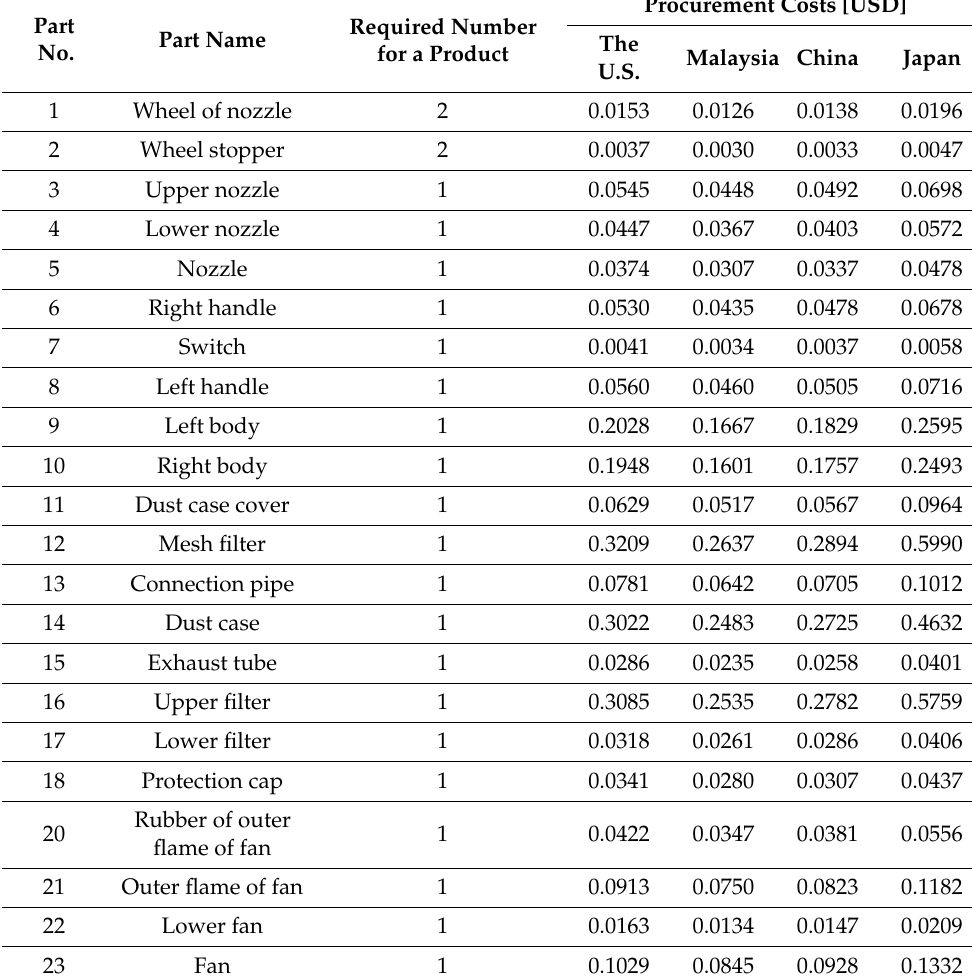
Table A3. BOM of the parts and procurement costs.